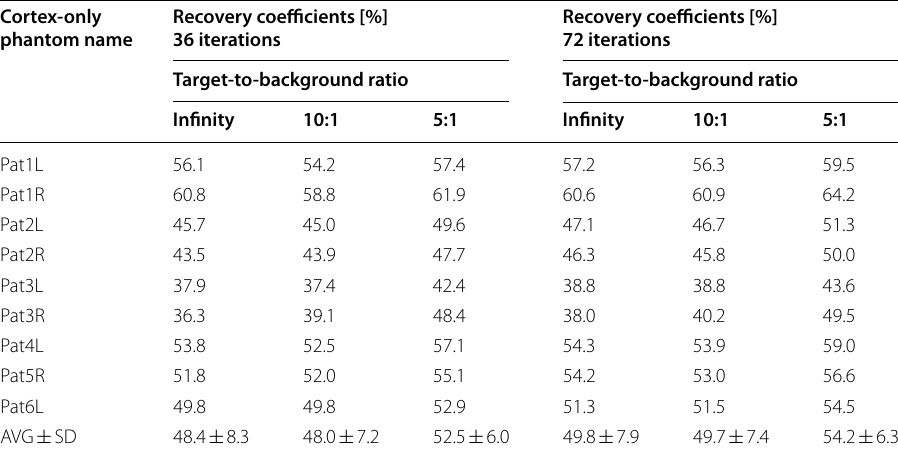
The AVG SD row denotes the averages plus/minus one standard deviation of all cortex-only phantom RCs. Values were ± obtained for LEHR collimation and the radionuclide 99m Tc